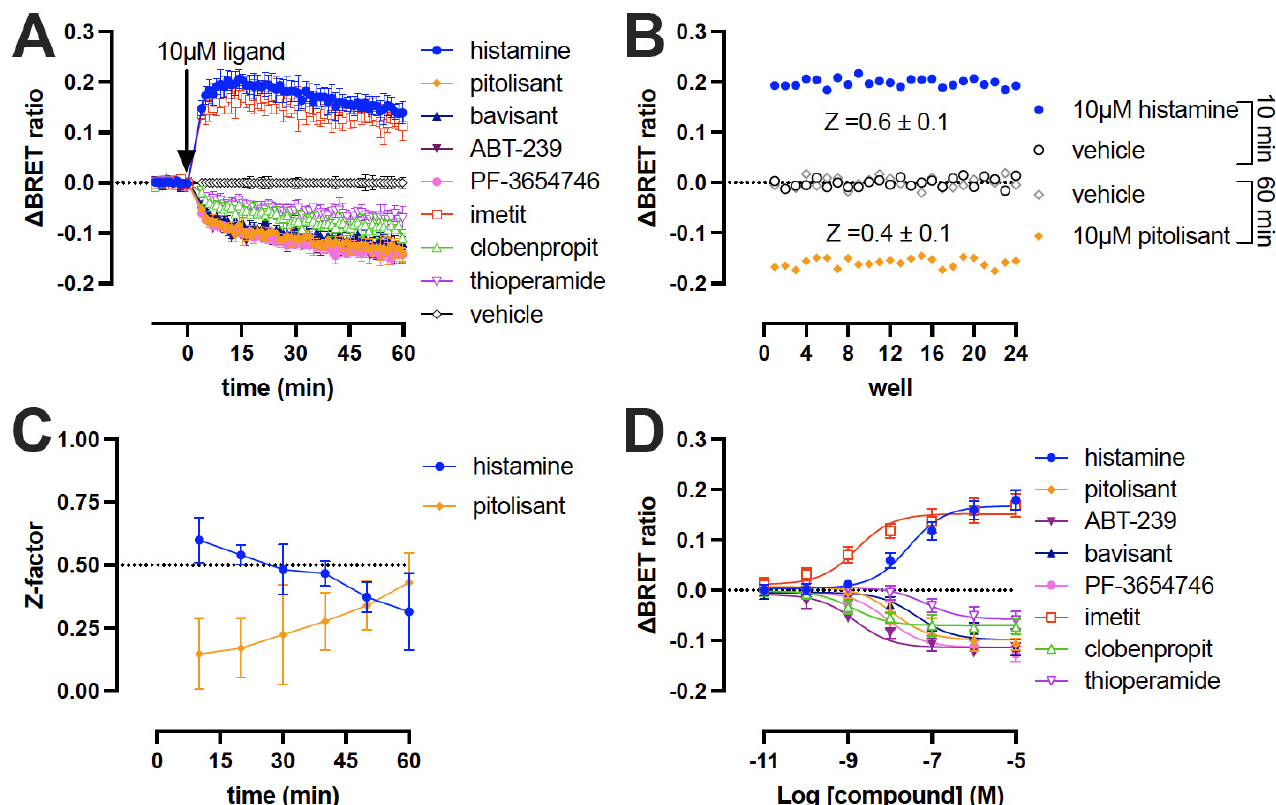
Figure 3. BRET responses of H 3 R ligands determined on Δ icl3-H 3 R Nluc/Halo(618) cell membrane pre- pared in 50 mM Tris-HCl (pH 7.4). ( A ) Δ BRET time course of eight H 3 R ligands at 10 μ M